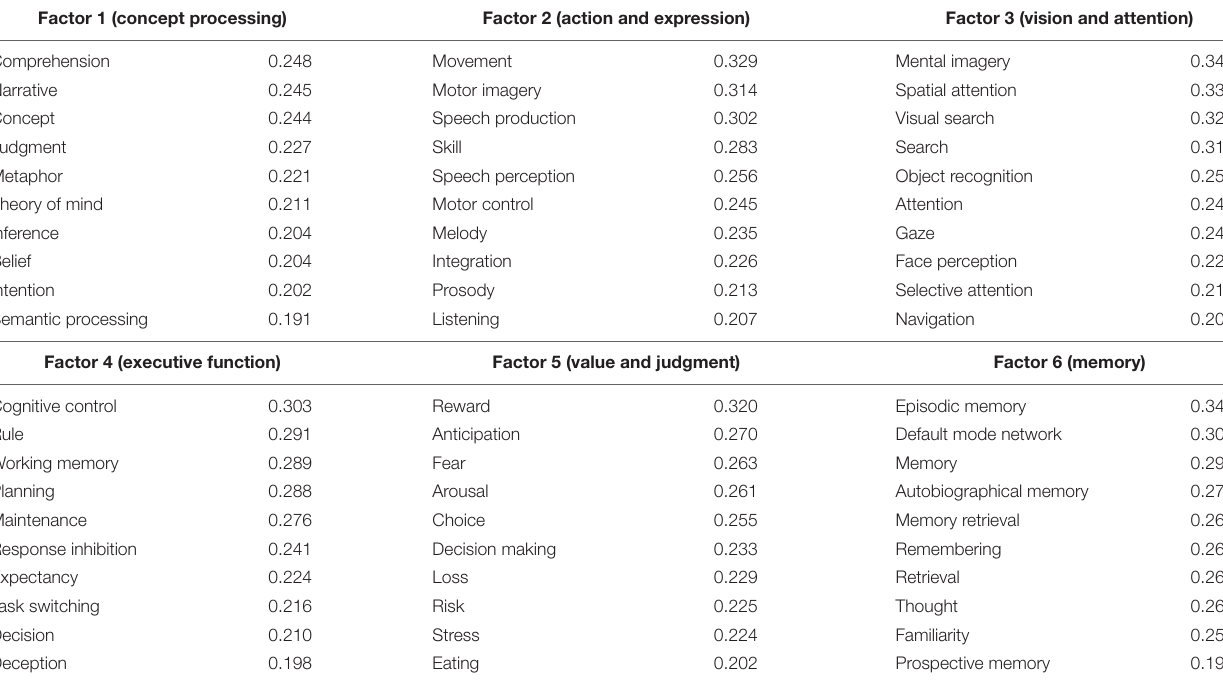
TABLE 2 | Cognitive factors defined using non-negative matrix factorization of the parcel-to-CFM RSFC matrix. Factor 1 (concept processing) Factor 2 (action and expression) Factor 3 (vision and